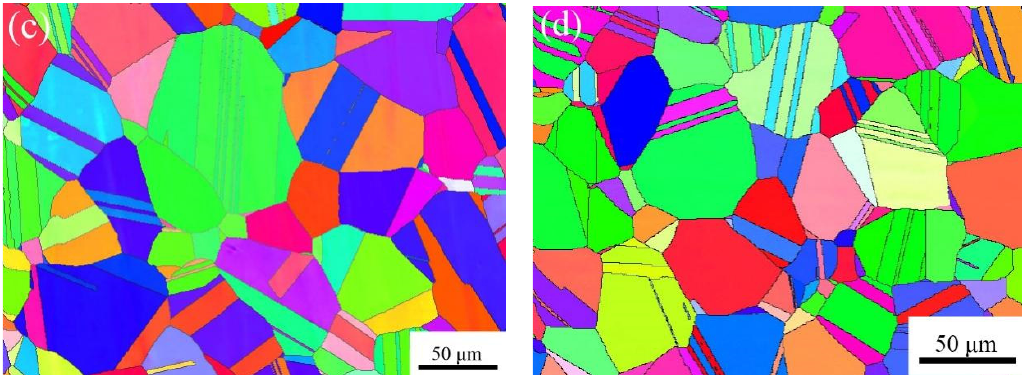
Figure 8. Orientation imaging maps of Ni-36.6W-15Co after annealing for ( a ) 10 min, ( b ) 30 min, ( c ) 60 min and ( d ) 120 min at 1150 °C.